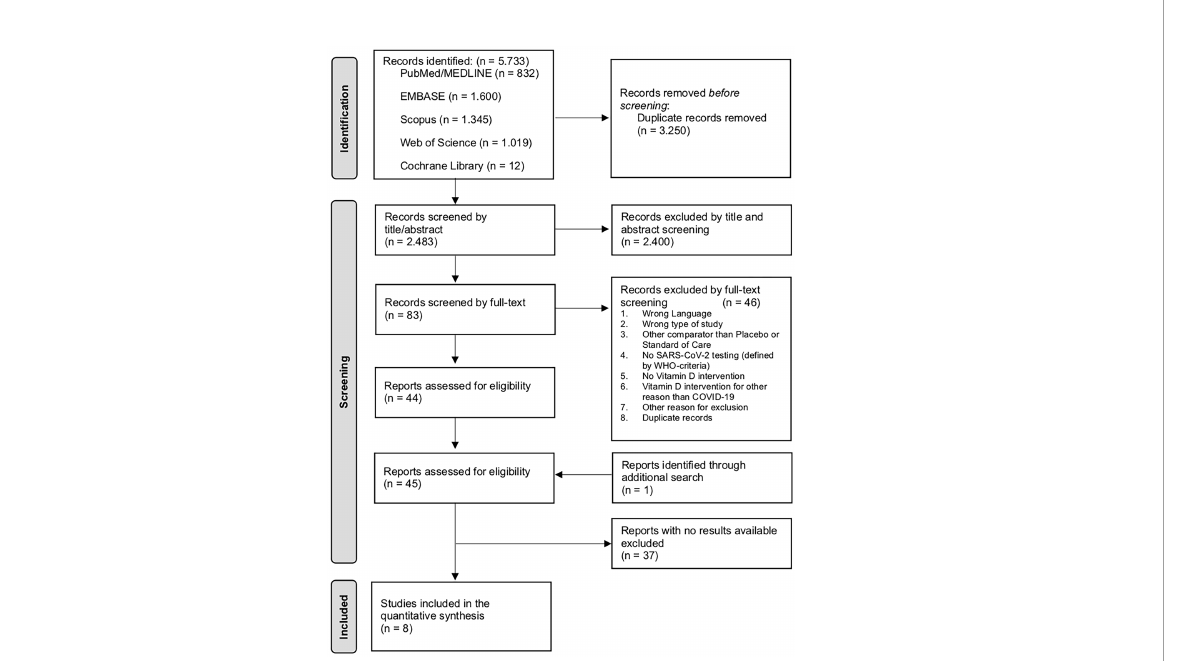
FIGURE 1 PRISMA fl owchart showing the study selection process to identify trials on vitamin D supplementation for the treatment and prevention of COVID-19. COVID-19, coronavirus disease 2019; SARS-CoV-2, severe acute respiratory syndrome-related coronavirus 2; WHO, World Health